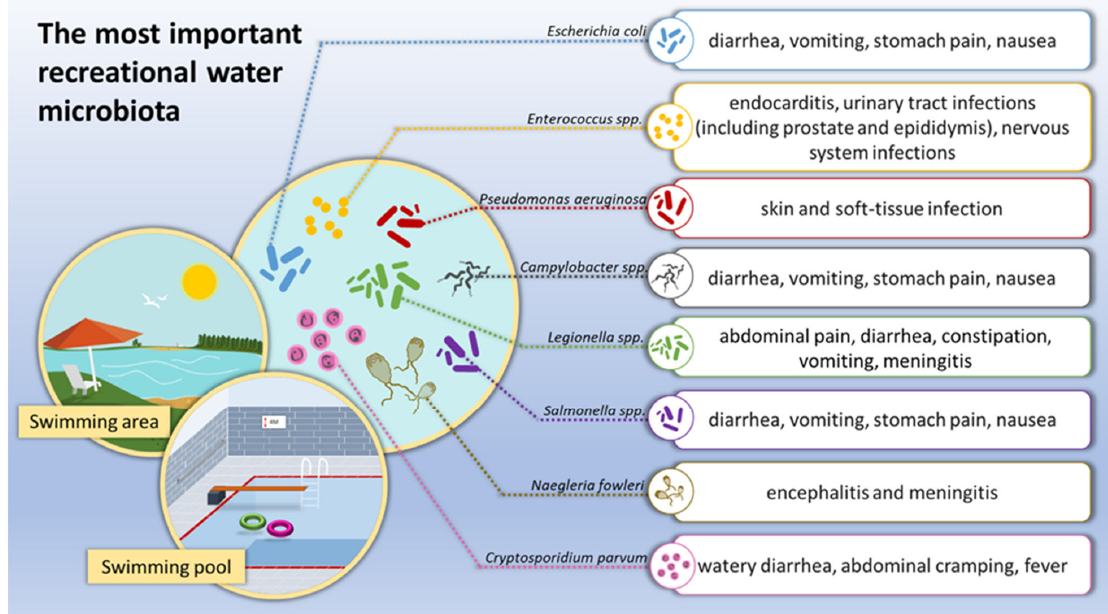
Figure 1. The most important microbiological threats in recreational waters.